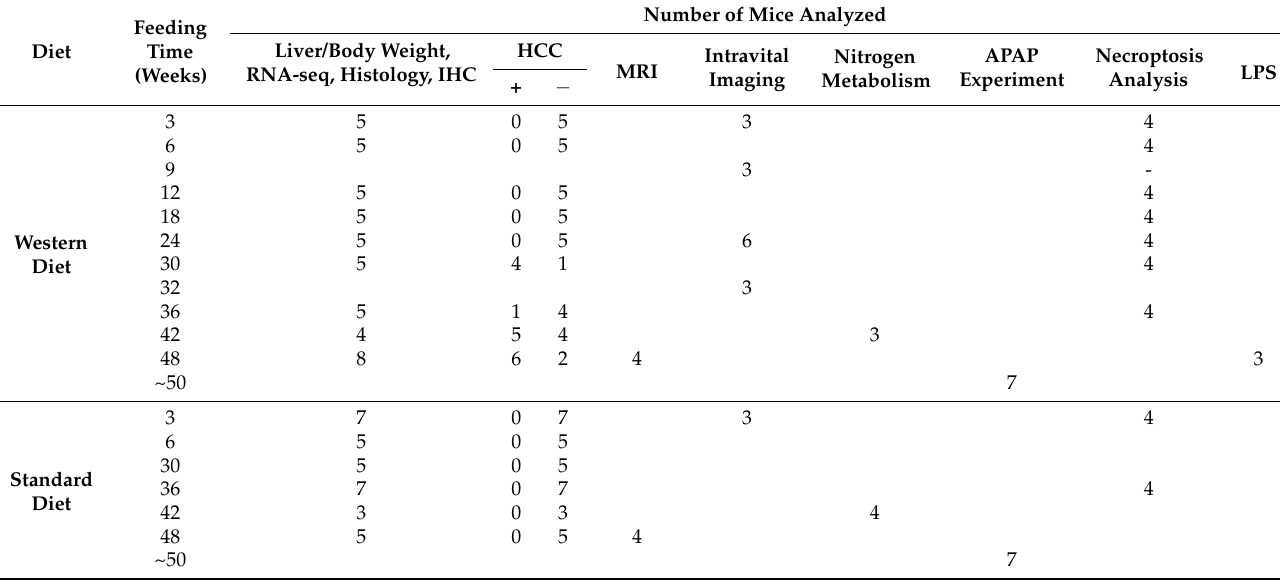
Table 3. Overview of the number of analyzed mice per experimental condition. Feeding